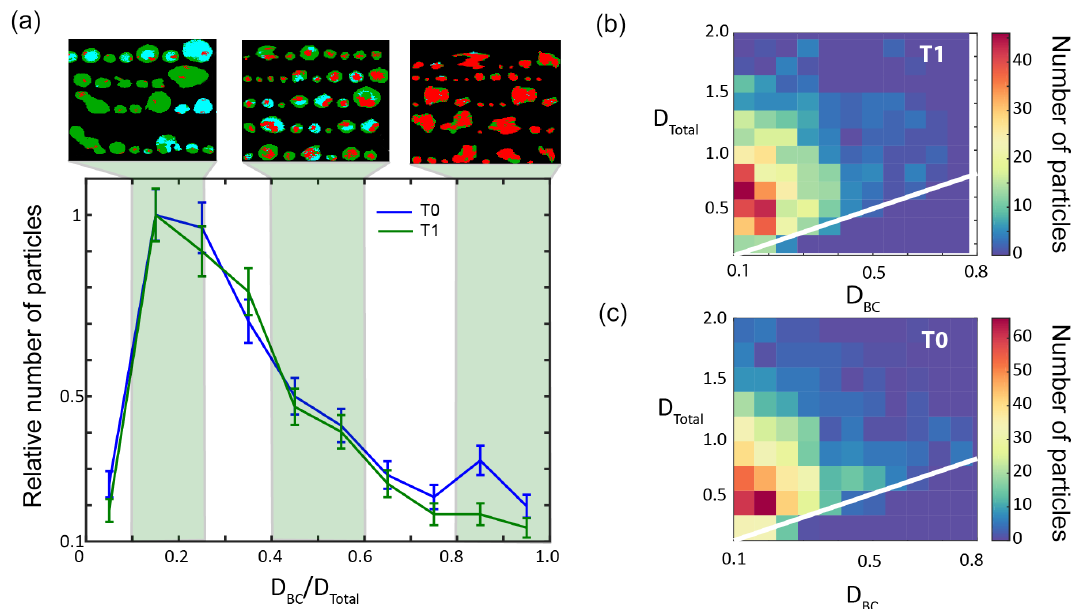
Figure 6. (a) Distributions of the ratio of the BC inclusion diameter to the total particle diameter ( D BC /D total ) after transmis- sion efficiency correction. Images shown above the plot are examples of particles having (from left to right) 0.1< D BC /D total <0.25, 0.4< D BC /D total <0.6, and 0.8< D BC /D total <1.0. ( b , c ) Two-dimensional histograms showing the number of particles having a total diameter D total and a BC core diameter D BC for T0 (c) and T1 (b) . White lines indicate 1 : 1